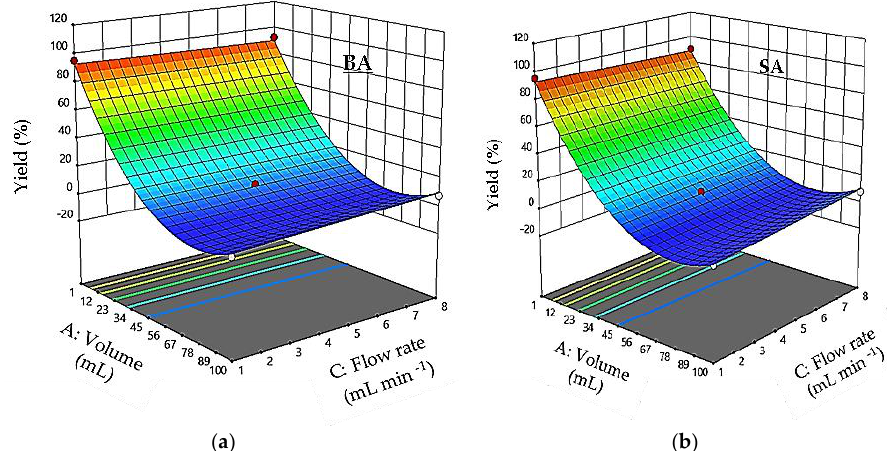
Figure 3. Response surface plots showing the effect of the sample volume and pH on percolation